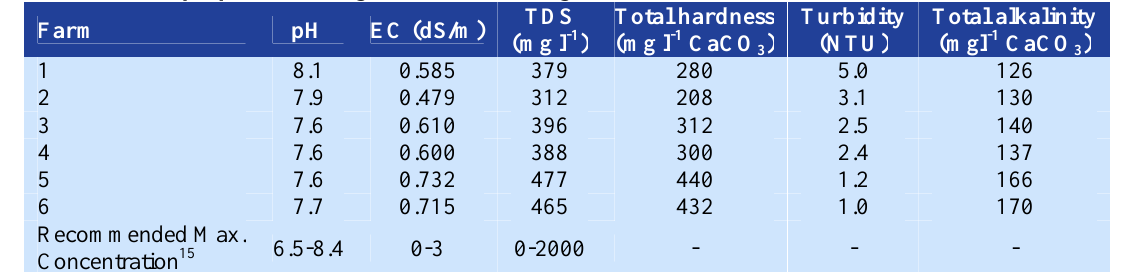
Recommended Max.